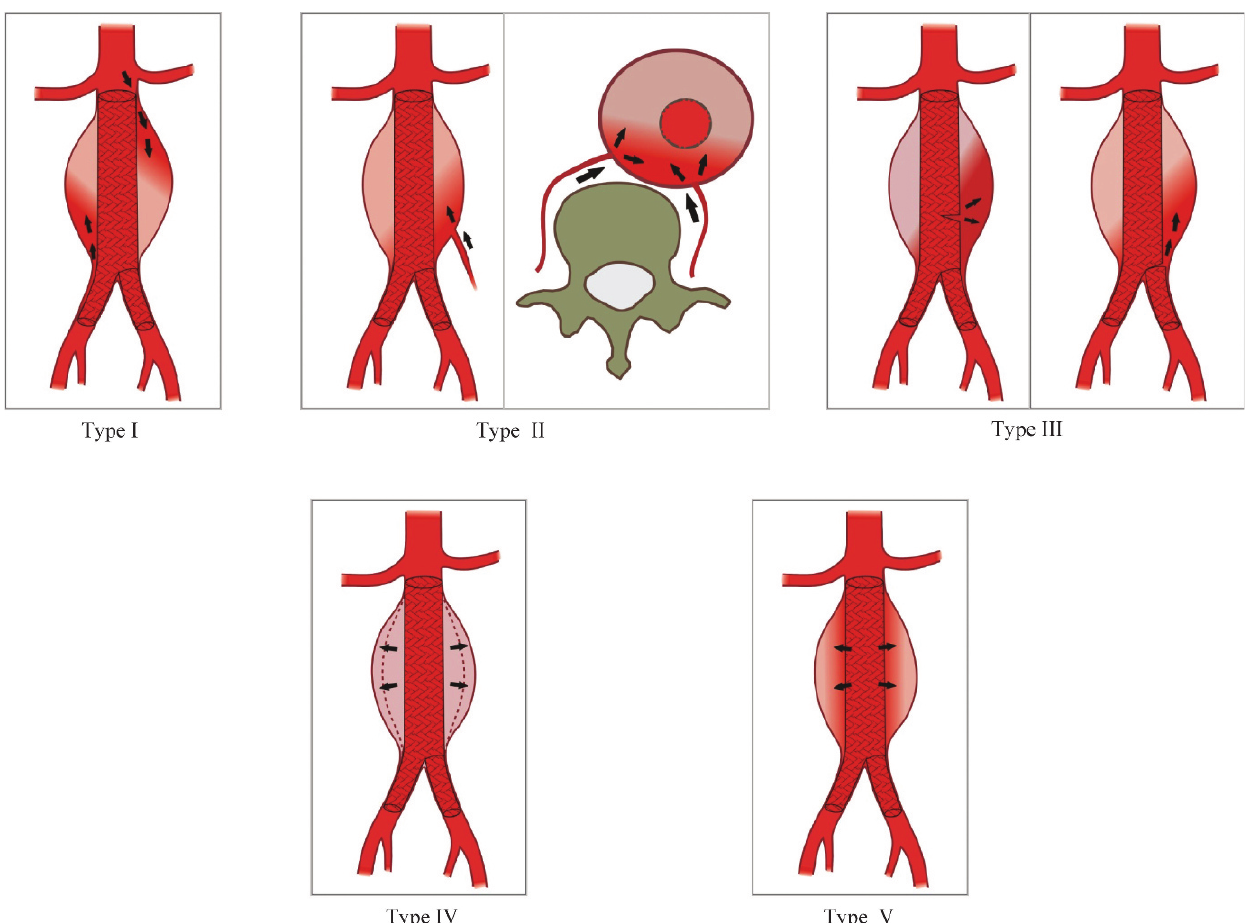
Figure 1 - Illustration of endoleaks using the Veith classification (Veith et al.